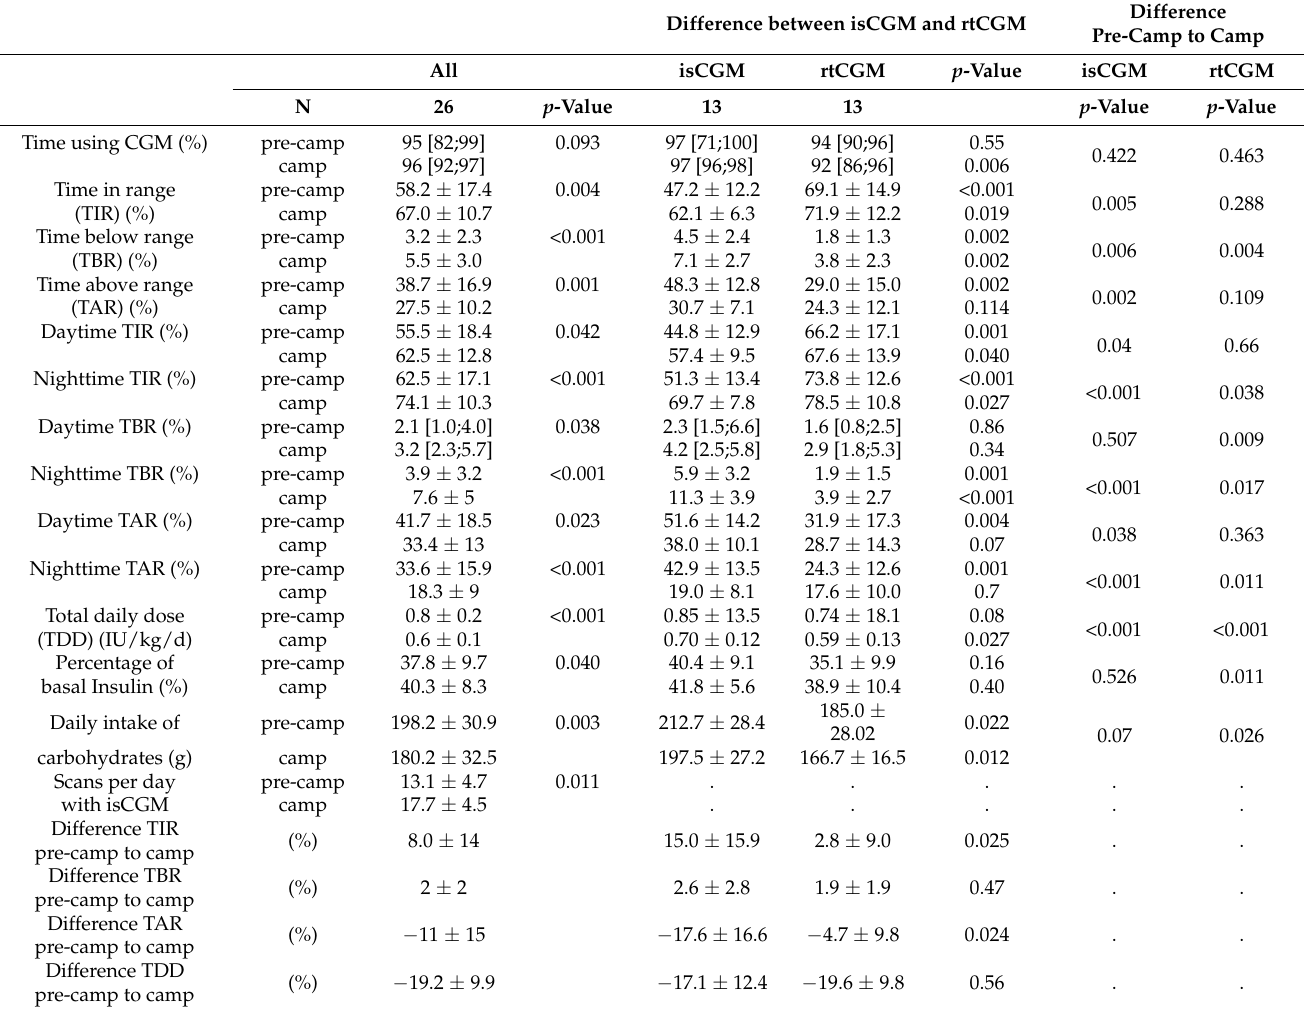
Table 2. Glycemic Control before and during